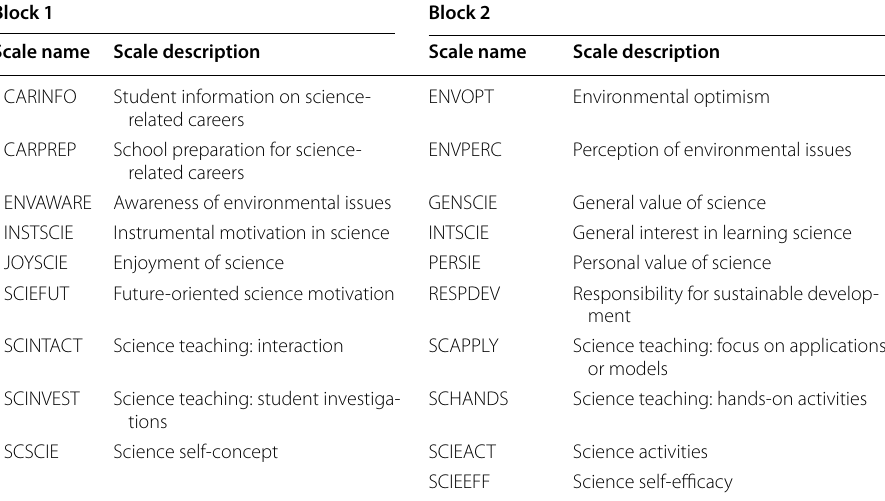
HIGHCONF, INTCONF, PRGUSE and INTUSE were excluded from the matrix sampling design because of no USA data in these four variables